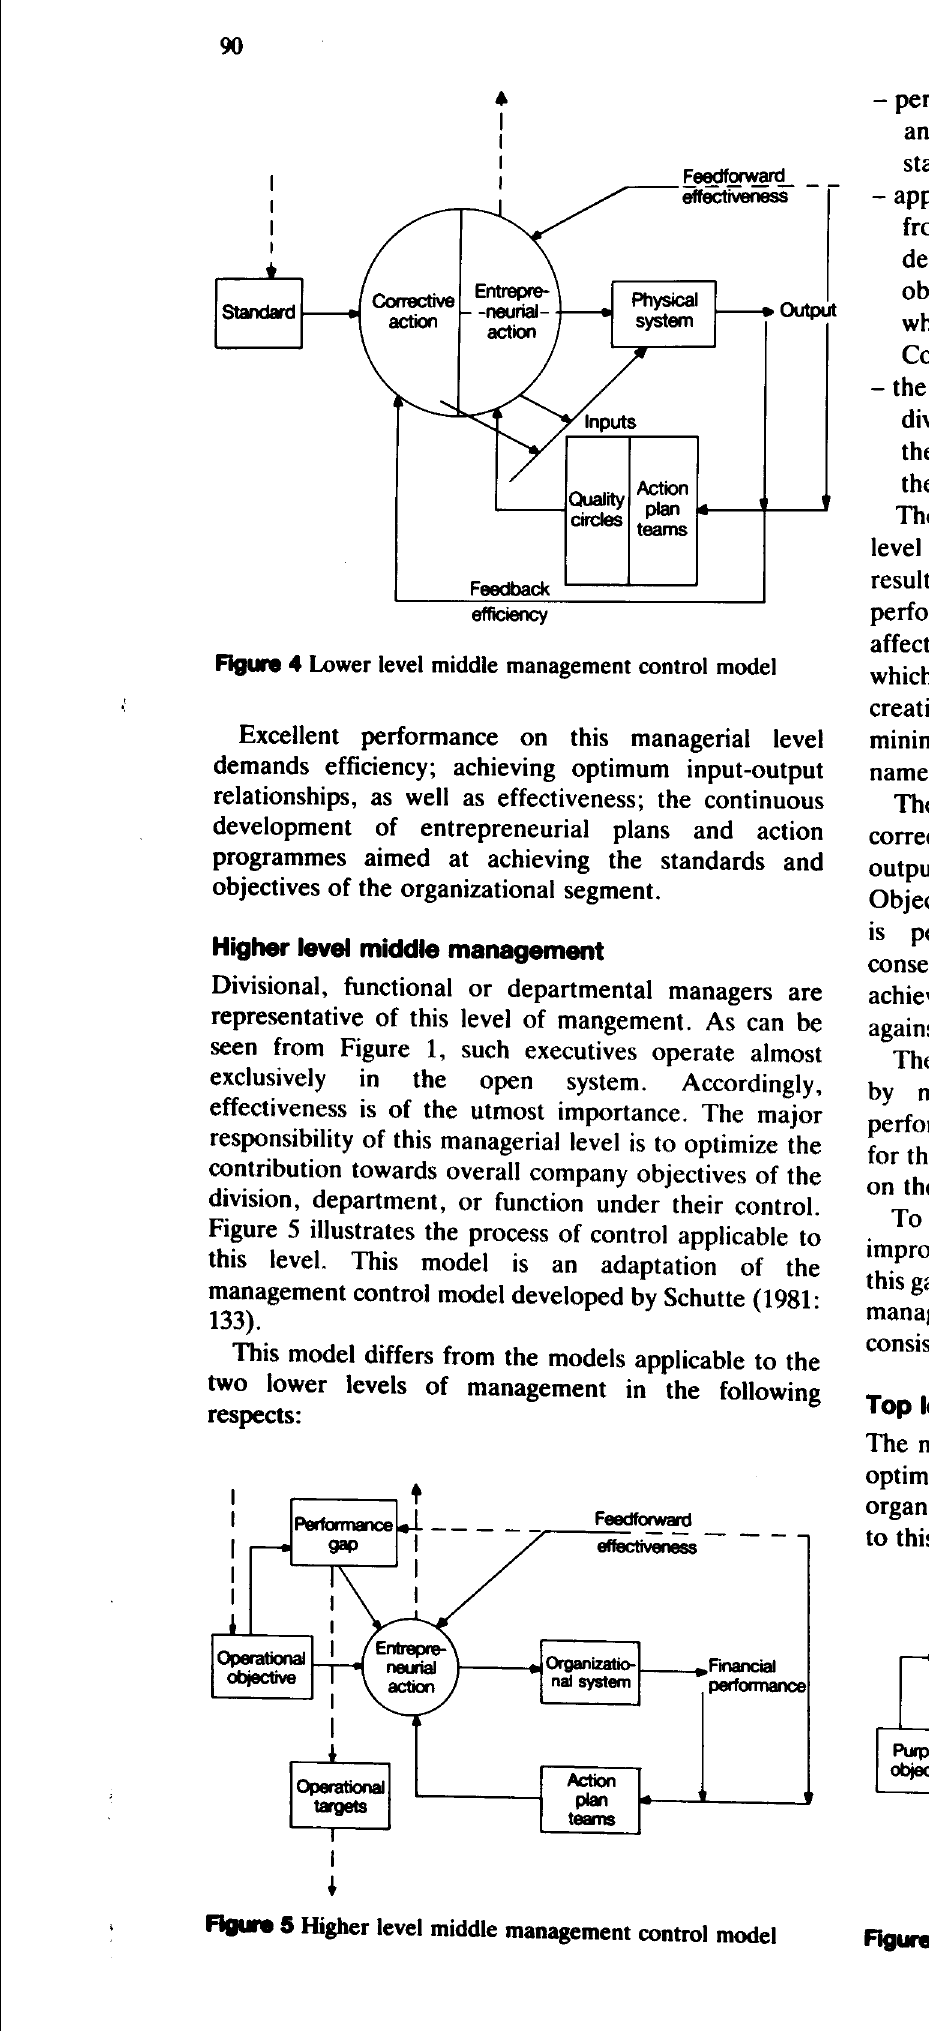
Figln 5 Higher level middle management control model